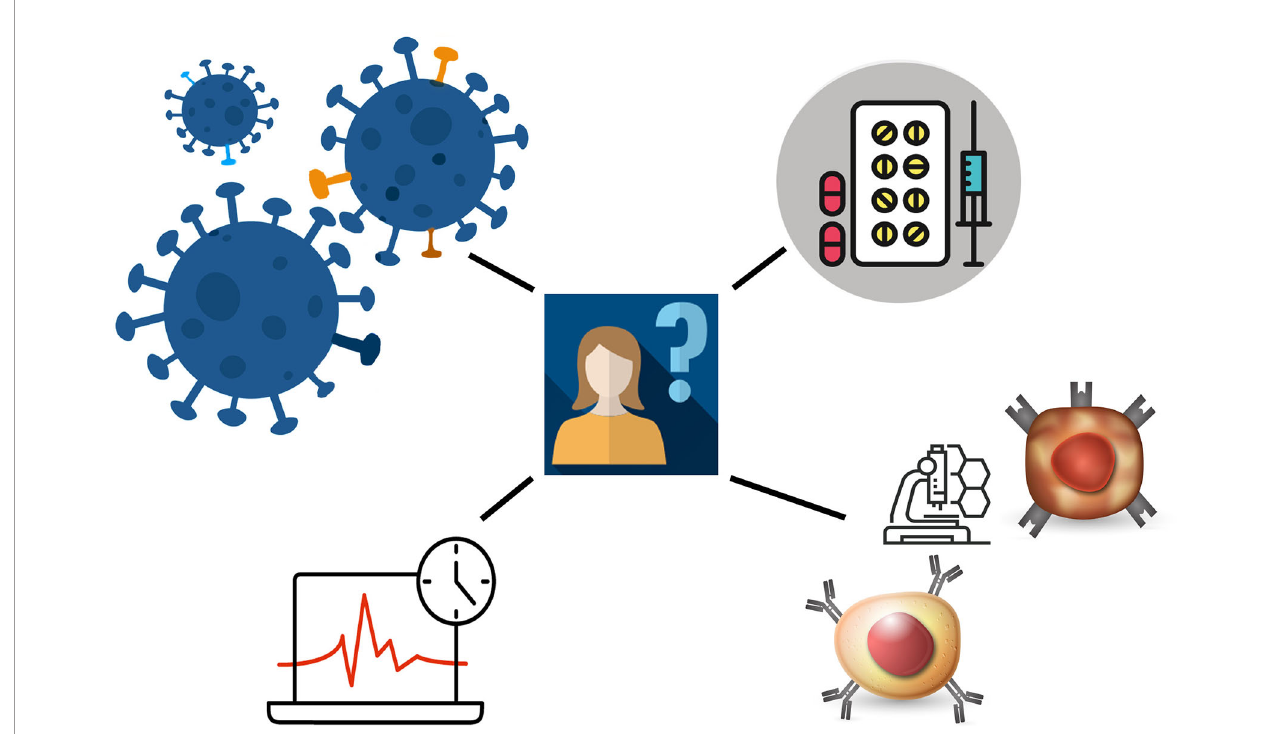
FIGURE 1 | Open questions concerning SARS-CoV-2 vaccination in MS patients. Several issues regarding the vaccination against COVID-19 in MS patients still need to be addressed by further studies. For one, it is not clear, whether vaccination is as ef fi cacious in patients receiving immunomodulating therapies as it is in healthy people. Second, the immunological equivalent of a protective immune response to vaccination has not been determined yet – are B cells and antibodies essential, is a speci fi c T cell response needed? Furthermore, the durability of immune responses after vaccination is unknown. Lastly, it needs to be observed whether SARS-CoV-2 generates mutants that escape protection of a vaccine-elicited immune